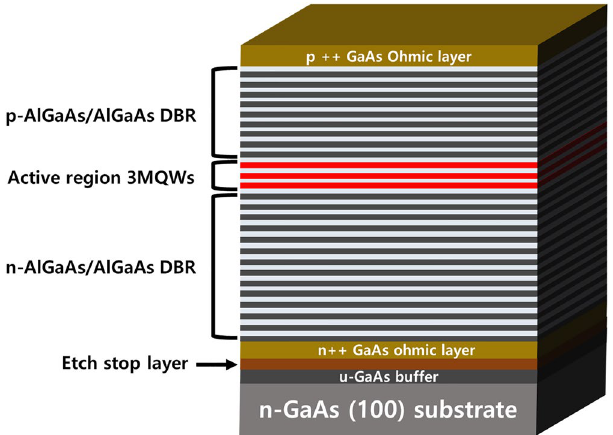
Figure 2. p-on-n structure of the thin-film VCSEL by MOCVD. Etch stop layer was grown on the GaAs buffer to protect the upper epitaxial layers during the removal of the GaAs substrate with the NH 4 OH-based